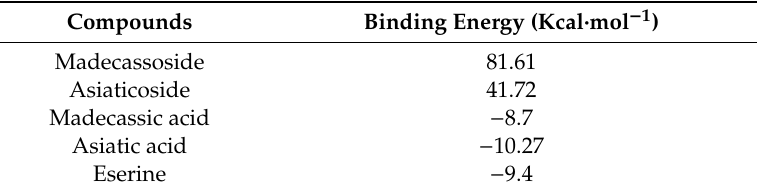
Table 5. Estimated binding energy of triterpenes in the active sites of